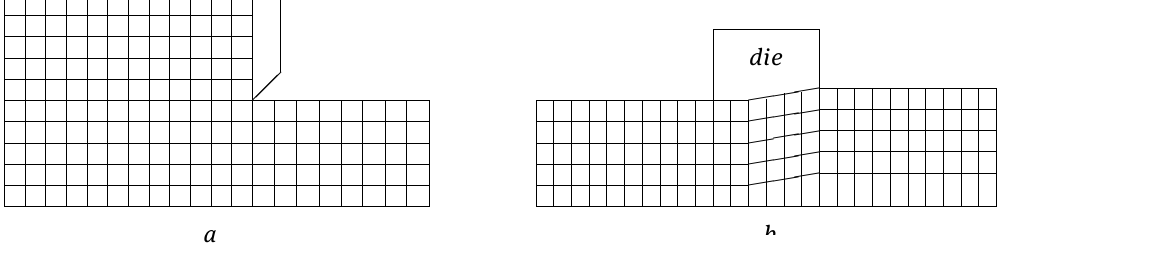
Fig. 2. Finite element meshes for the example extrusion and drawing problems.